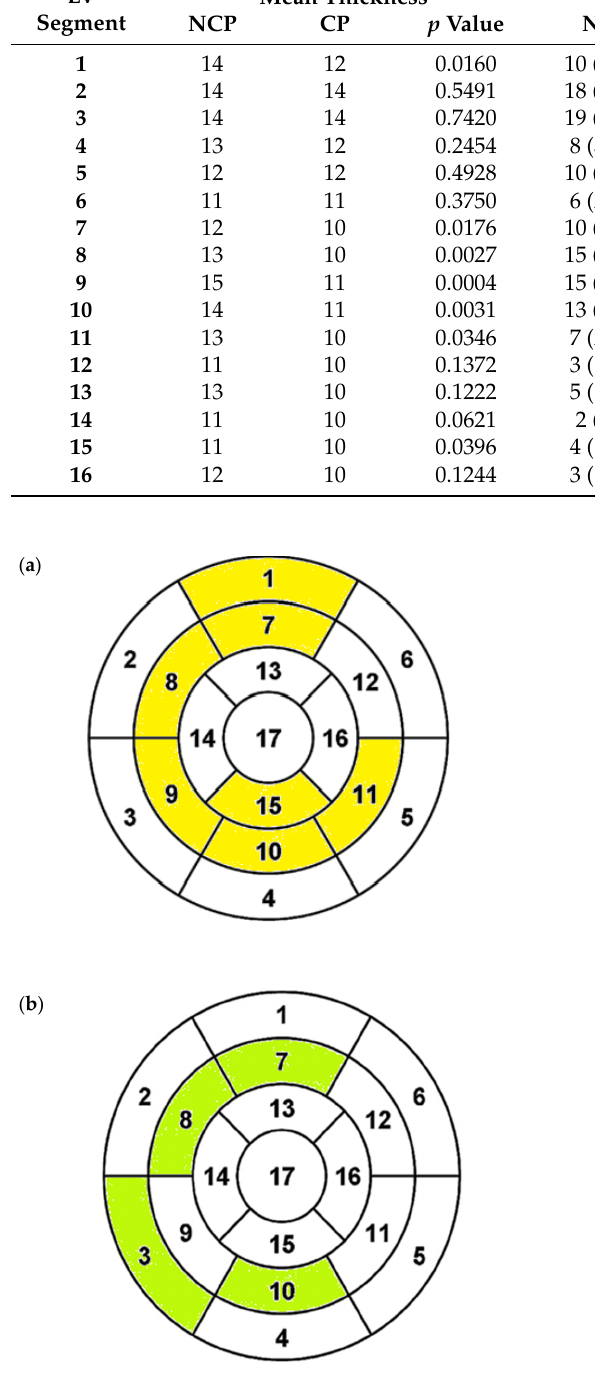
Figure 5. ( a ) Segmental myocardial thickness—in NCP (nonclassic phenotype), greater mostly in midsegments (marked as yellow); ( b ) segmental LGE (late gadolinium enhancement) distribution. The usual locations of LGE areas in HCM (hypertrophic cardiomyopathy) were insertion points of the right ventricle and focal areas in hypertrophied regions. In the NCP group, the enhancement was more frequent beyond the insertion points, indicating more extensive distribution (marked as green).